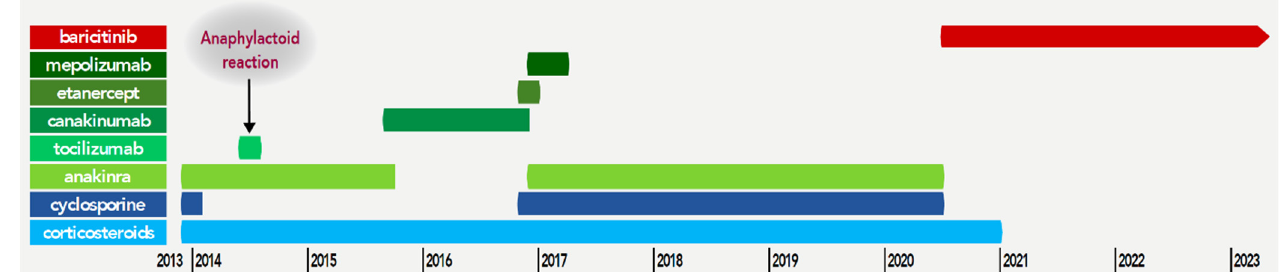
Figure 2. Different lines of treatment.